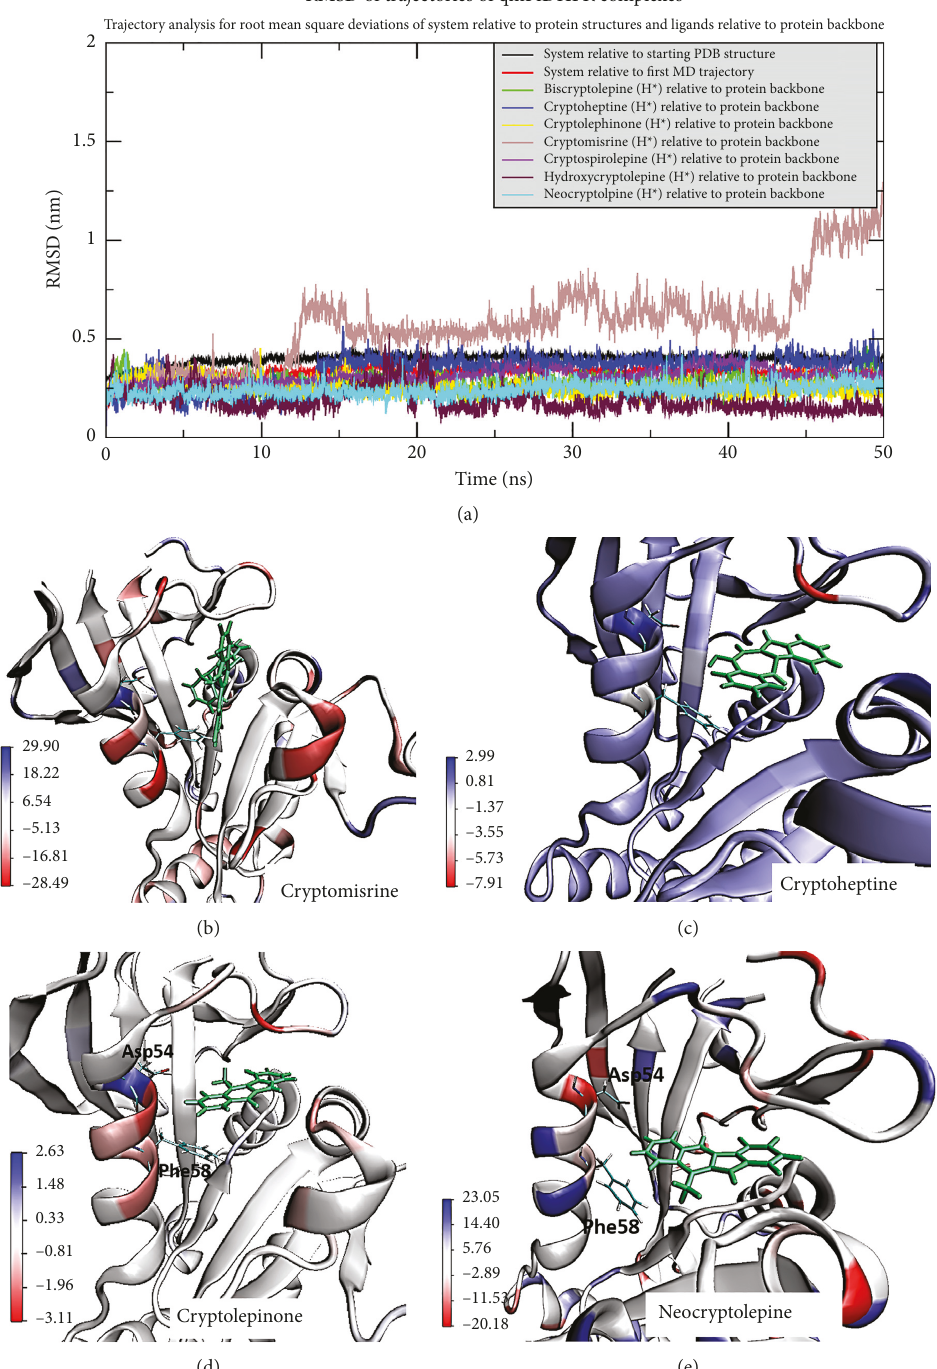
Figure 11: Binding conformation predicted from molecular docking was stable under dynamic conditions. (a) Trajectory showing stability of protein ligand complexes for qm- Pf DHFR. High steric advantage of cryptomisrine (brown line) enhanced interactions with pocket residues, hence an overall reorganization of the starting structure to attain an effective binding conformation (RMSD between 13ns and 50ns of the trajectory fluctuated in the range between 0.5nm and 1.3nm). (b–e) Interacting residues contributing to binding affinity have been colored based on b-factors. Neocryptolepine-Asp54 interaction contributed to overall complex